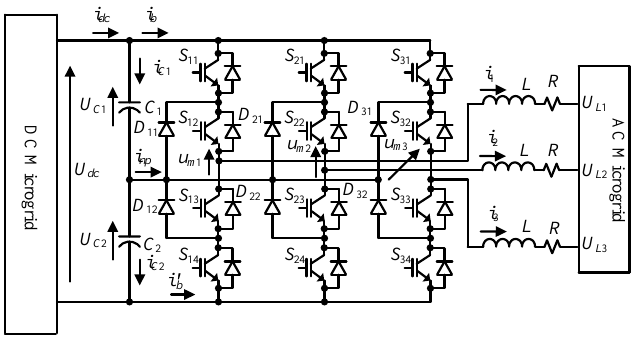
Figure 4. NPC converter circuitry interconnecting a hybrid microgrid.